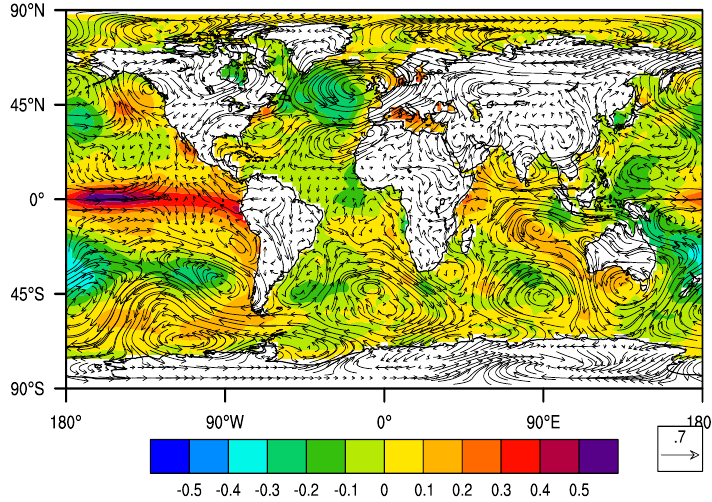
Figure 9. Low level winds (850 hPa) and sea surface temperature anomalies composites for EOF1 during the Short Rains for enhanced rainfall over the East Africa domain using the TRMM timeseries.